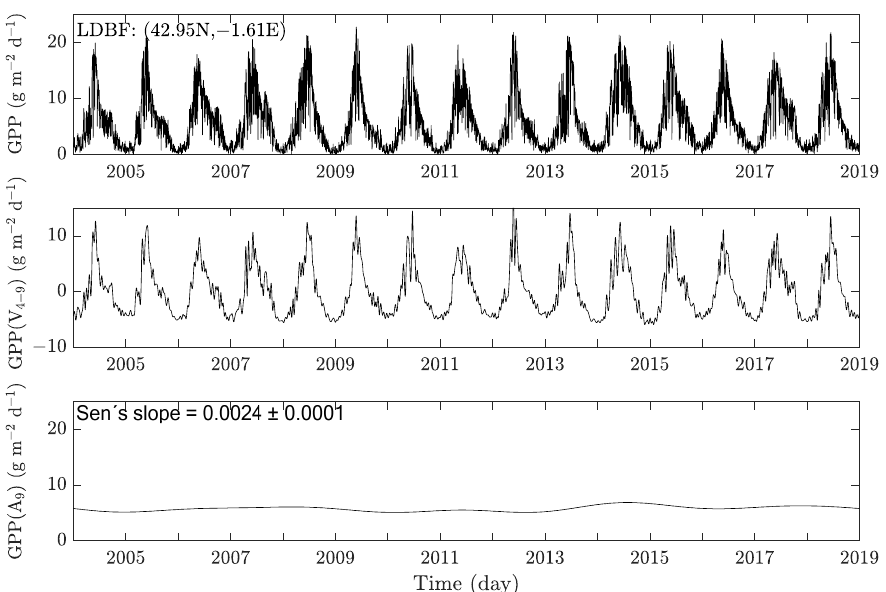
Figure 2. Example of MRA-WT decomposition for the GPP (g m − 2 d − 1 ) TS of a deciduous broadleaved pixel. The top panel refers to the original GPP TS. The center panel refers to the variability of the original signal V 4–9 . The bottom panel shows the interannual A 9 component.